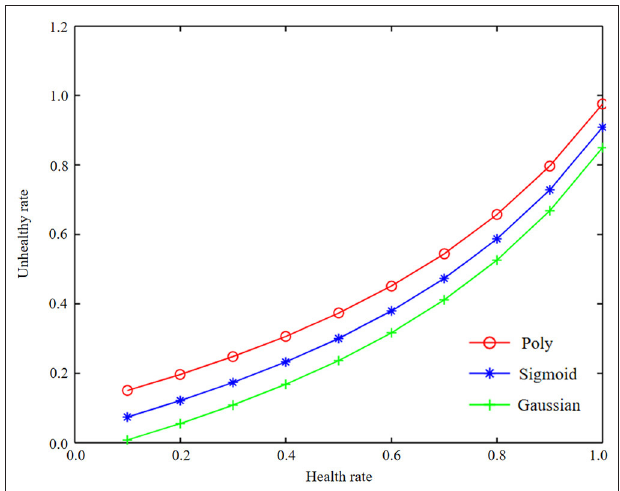
FIGURE 10 | ROC curve performance of three kernel functions under machine learning combined